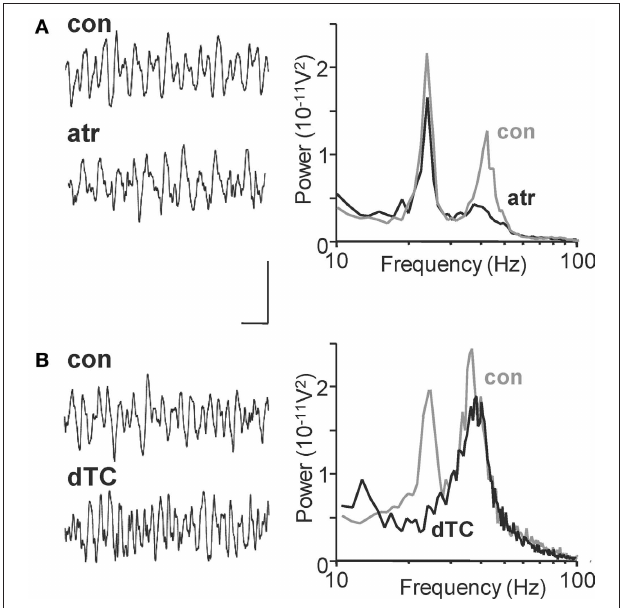
FiGurE  | Nicotinic and muscarinic cholinoceptors differentiate between layer ii/iii gamma and layer  beta cholinergic rhythms in Au. (A) Example traces of field potential activity from layer IV in the 1 ° auditory cortex after carbachol (15 μM) application (con) and subsequent atropine (100 nM) application (atr). Spectra on the right show pooled frequency content from n = 5 experiments showing selective blockade of gamma rhythms with muscarinic receptor blockade (black trace). (B) Corresponding 500 ms recordings of layer IV extracellular activity in the presence of carbachol (con) and after application of d-Tubocurarine (10 μM, dTC). Spectra show pooled activity from n = 5 60 s epochs of field recording illustrating the selective blockade of beta rhythms with nicotinic receptor antagonism. Scale bar for traces = 100 μV, 100 ms.